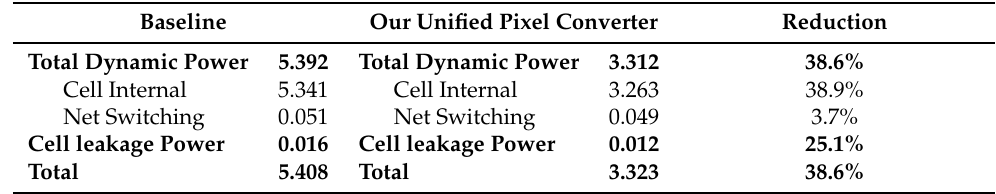
Table 4. Power consumption comparison